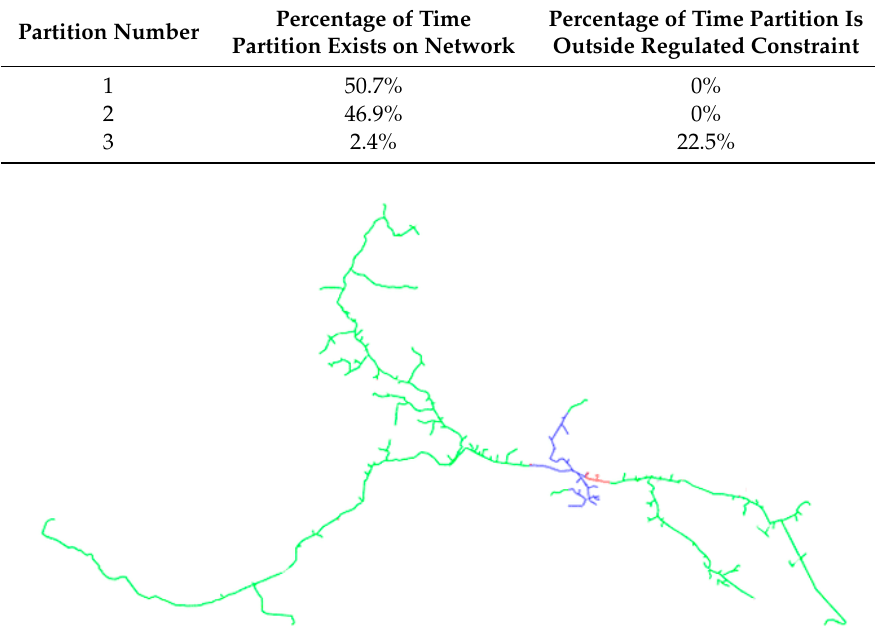
Figure 18. Metrics calculated for Case 3. ( a ) Average error ∆ of the secondary voltages between the results of consecutive power flows. ( b ) Maximum absolute error ∆ max of the secondary voltages between the results of consecutive power flows. Table 4. Results of Monte Carlo simulations for each partition in Case 3.